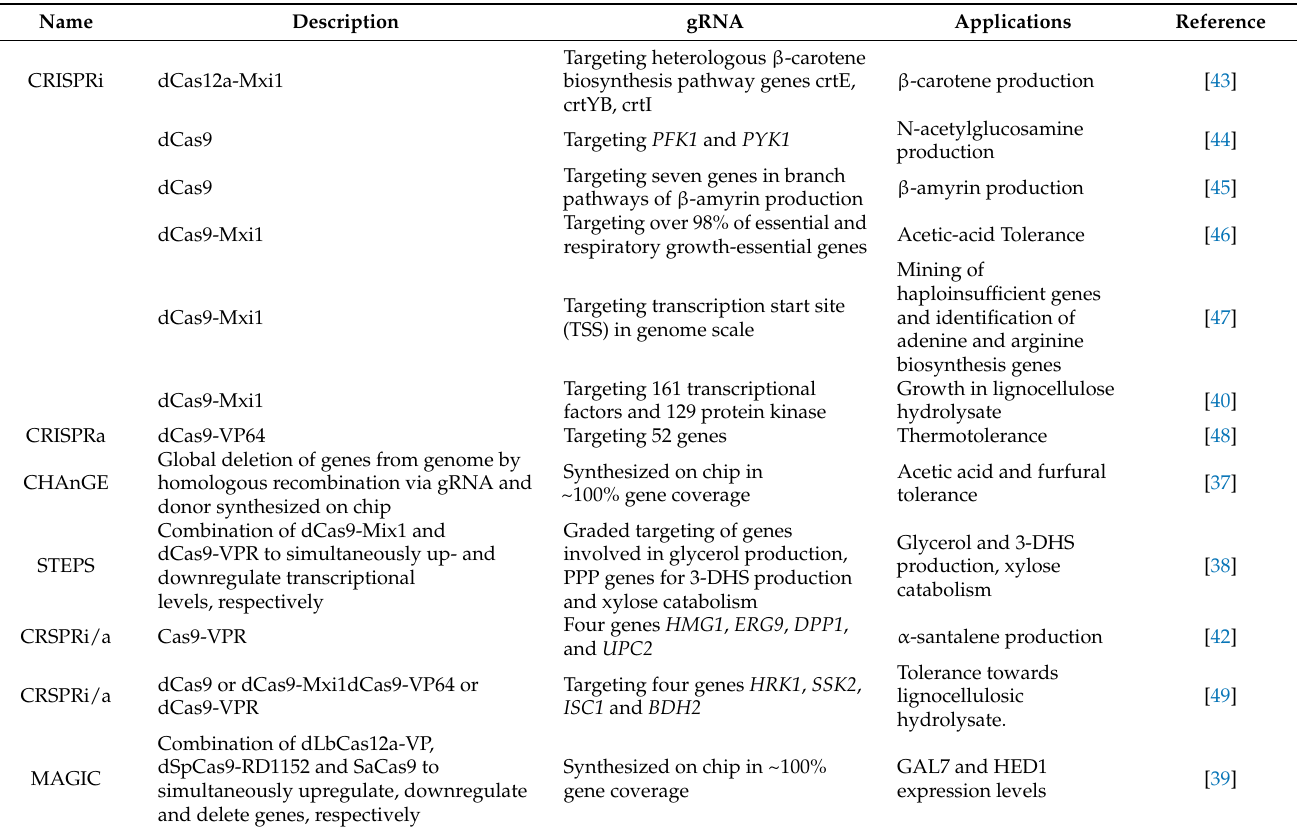
Table 1. Genome evolutionary-engineering methods by